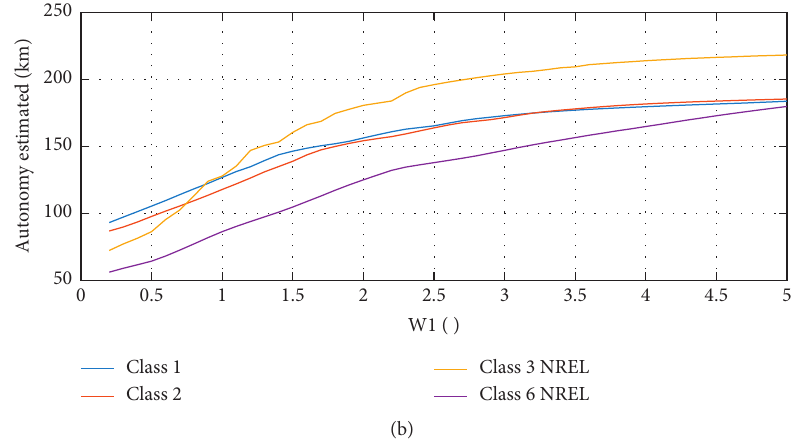
Figure 9: Autonomy expected versus β